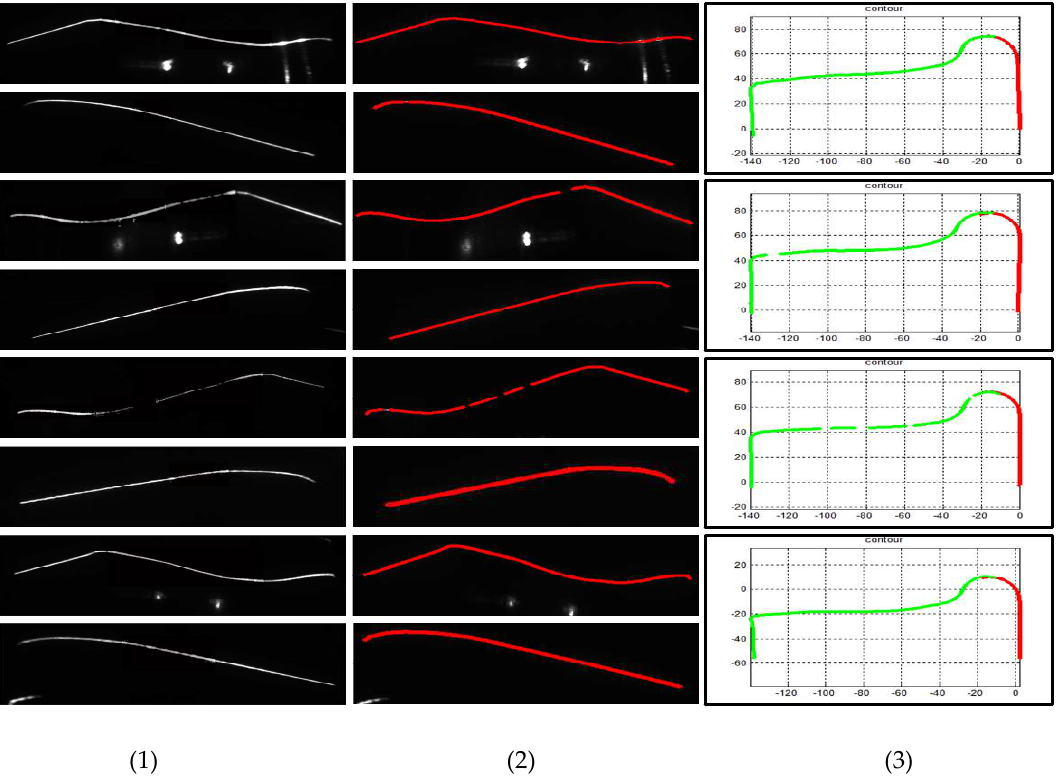
Figure 18. Wheel cross contour reconstruction with image processing. Column ( 1 ) presents the raw images. Column ( 2 ) shows the center extraction results of (1). Column ( 3 ) displays the wheel cross contour results of each wheel. Table 4. Measurement accuracy of wheel size by using different methods